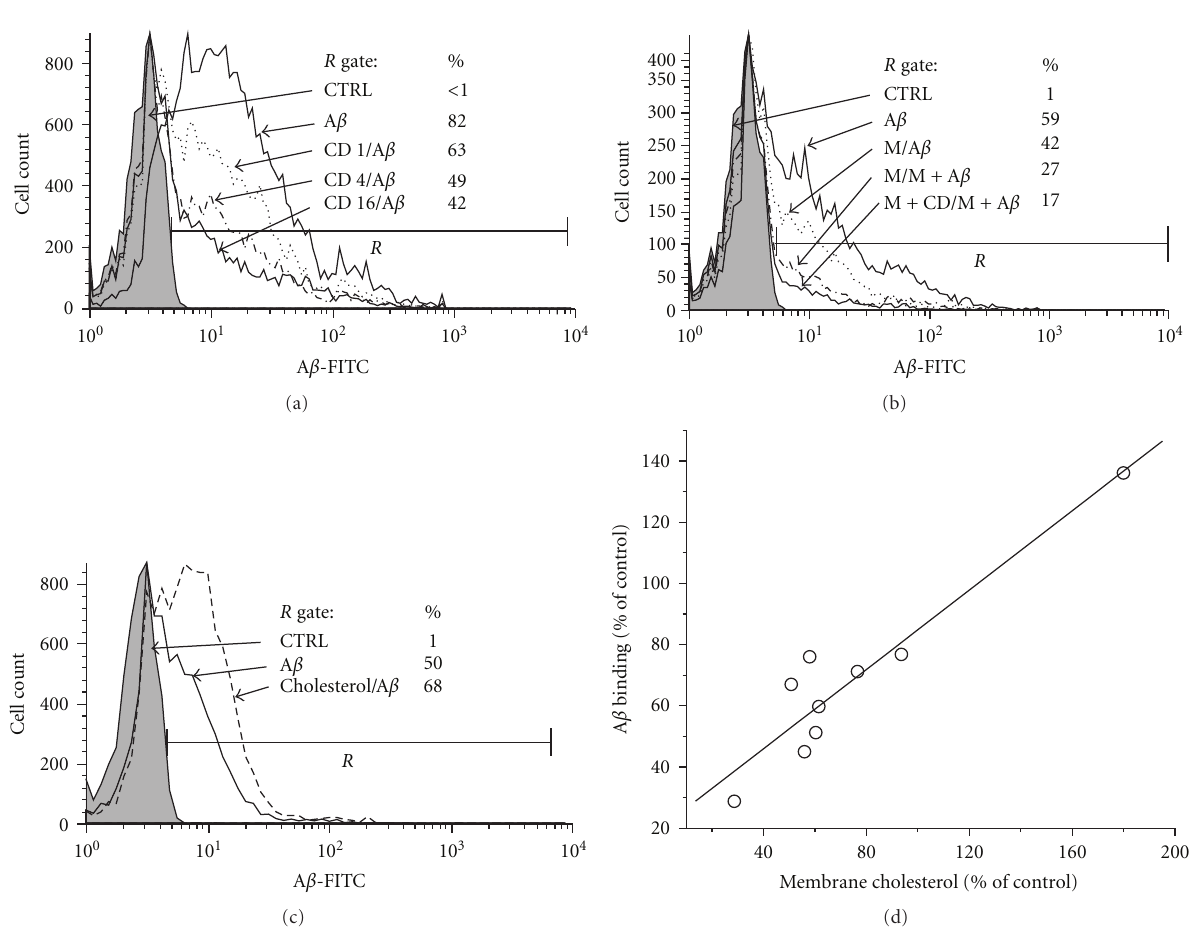
Figure 7: Correlation between A β -FAM binding and the levels of cholesterol in the membrane over a wide range of membrane cholesterol. To vary the levels of cholesterol in the cell membrane, PC12 cells were treated with di ff erent concentrations of methyl- β -cyclodextrin (CD) (a), mevastatin ( M ), (b) and polyoxyethanyl-cholesteryl sebacate (Cholesterol) (c). Then, cells were exposed for 80 minutes to A β -FAM and the fluorescence from the membrane bound A β -FAM was evaluated by flow cytometry. The percentage of cells in gate R (numbers in the figures) shows that enriching or depleting the cell membrane of cholesterol increases or reduces the levels of A β -FAM binding to the surface of the membrane. The plot in (d) compiles the percentage of A β + cells as a function of the level of cholesterol in the membrane recorded at the time when membrane-bound A β -FAM was measured. The straight line is the result of a linear relation fit of data ( R = 0 .